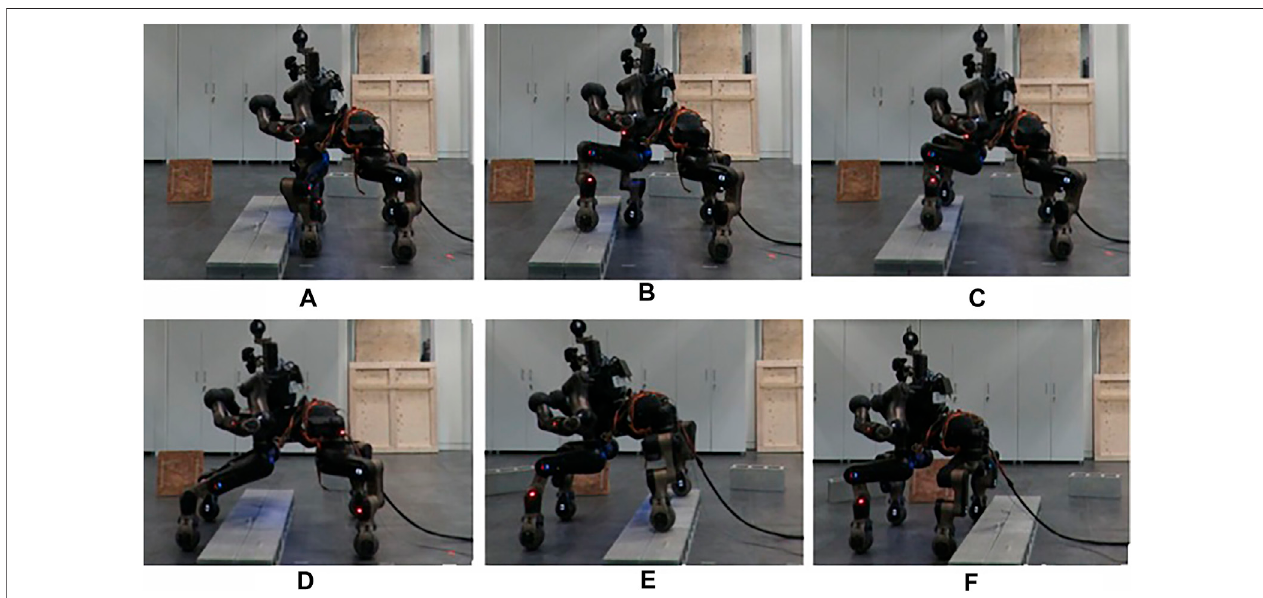
FIGURE 12 | Sequence of the stepping on strategy applied on the real robot with an Obstacle-B. (A) The robot is close to the obstacle, (B) step on with the front wheel, (C) step on with the front wheels, (D) step down with the front wheels, (E) step on with rear wheels, (F) robot completed the task, crossing the obstacle.